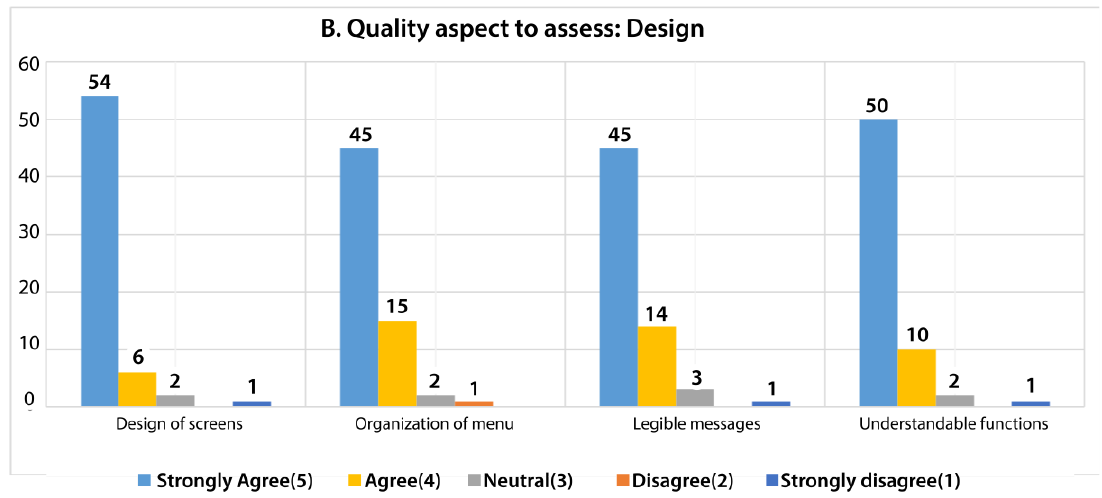
Figure 19. Evaluation of users about the design criteria.